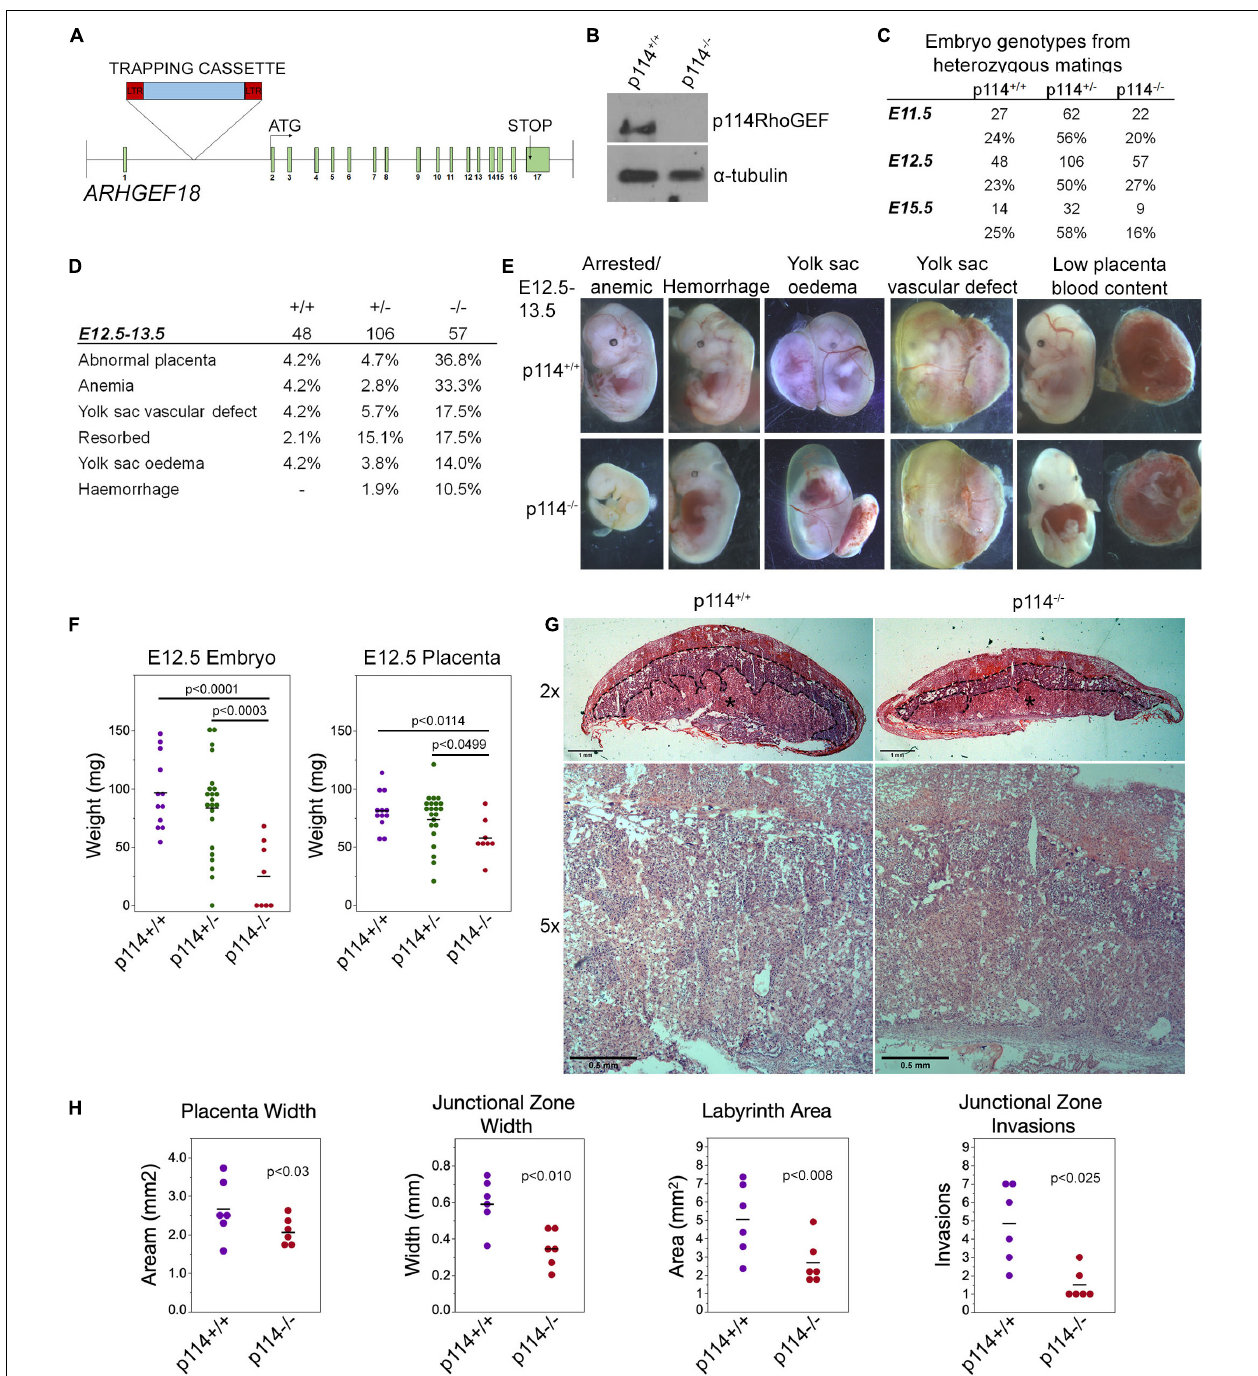
FIGURE 1 | Knockout of p114RhoGEF in mice is embryonic lethal. (A) Schematic representation of mutation strategy for generating the ARGEF18/p114 KO mouse (adapted from https://www.taconic.com/knockout-mouse/arhgef18-trapped). Indicated is the insertion site of the trapping cassette prior to the start initiation codon. (B) Immunoblot of samples generated from E12.5 embryos, indicating complete ablation of p114RhoGEF expression in p114 − / − embryos. (C) Analysis of embryos at E11.5, E12.5 and E15.5. Genotypes at E12.5 were at expected mendelian ratios but by E15.5, the percentage of p114 − / − embryos started to decrease due to embryonic arrest. (D,E) Analysis of p114 − / − phenotypes at E11.5 and representative images of phenotypes observed. (F) Analysis of embryo and placenta weights at E12.5. Shown are data points and means. Significance was tested with t -tests. (G) Hematoxylin and eosin (H&E) staining of 12 µ m placenta cryosections at E12.5. Note the decrease in thickness of the labyrinth layer in p114RhoGEF-deficient animals (asterisks). Junctional zones are indicated with dashed lines. (H) Quantification of placenta morphology from H&E sections. Shown are data points and means, n = 6 placentas per genotype. Paired t -tests were used to determine significance of differences observed in different litters. Bars: (G) , upper panel 1 mm and lower panel 0.5 mm.